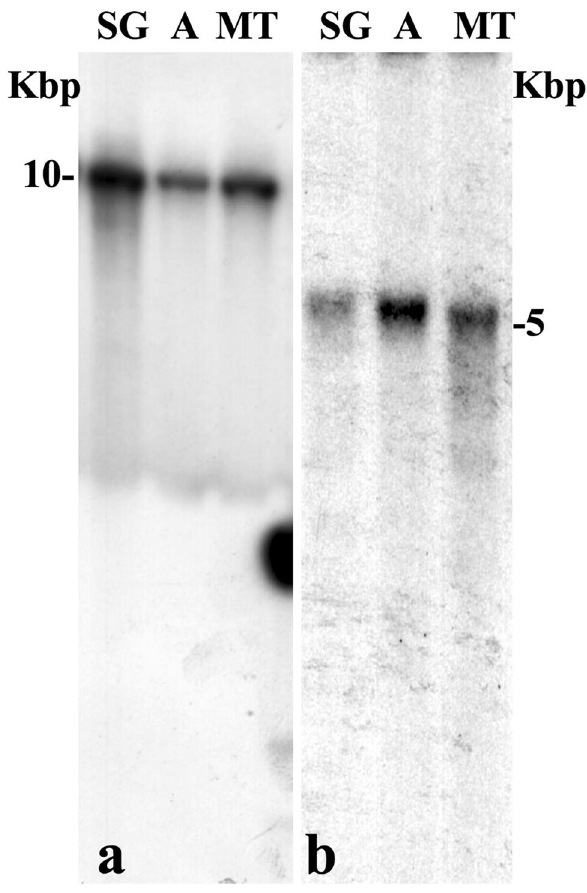
Figure 7. ( a , b ) Schwenkfeldina DNA from salivary gland (SG), adult flies (A) and Malpighian Tubules (TM) was cut with Eco RI, electrophorised in agarose gel, transferred to the nylon membrane and hybridised to rDNA ( a ) and histone gene ( b ) probes. Size markers in Kilobase pair